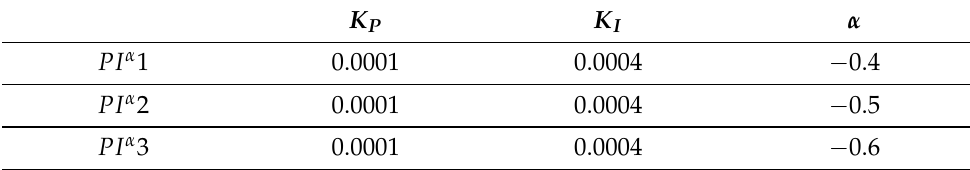
Table 1. The PI α controller